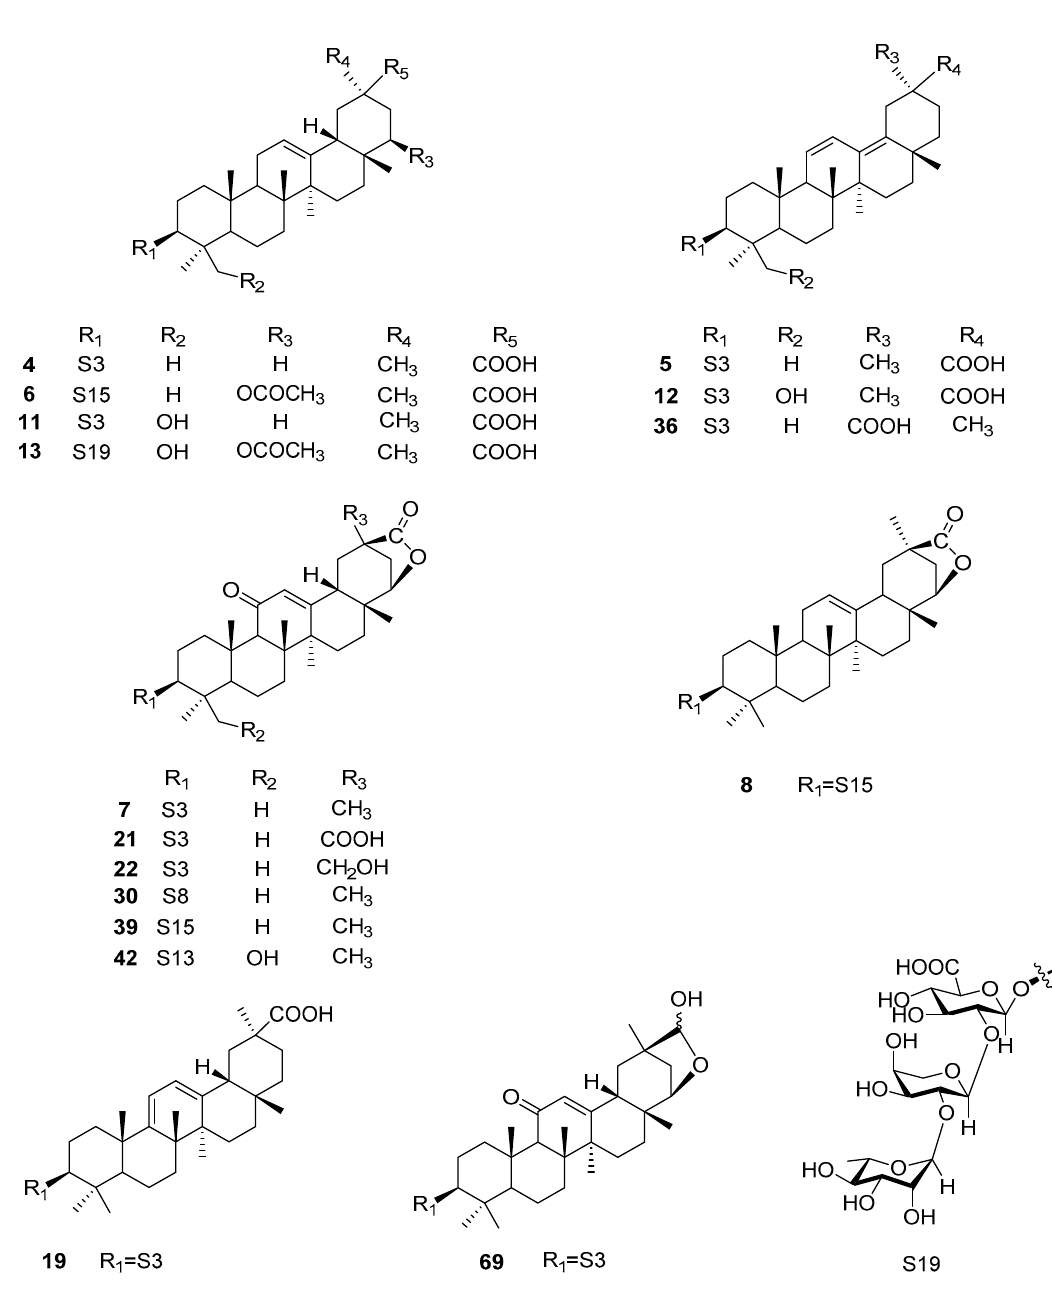
Figure 1. Triterpene saponins in G. uralensis.